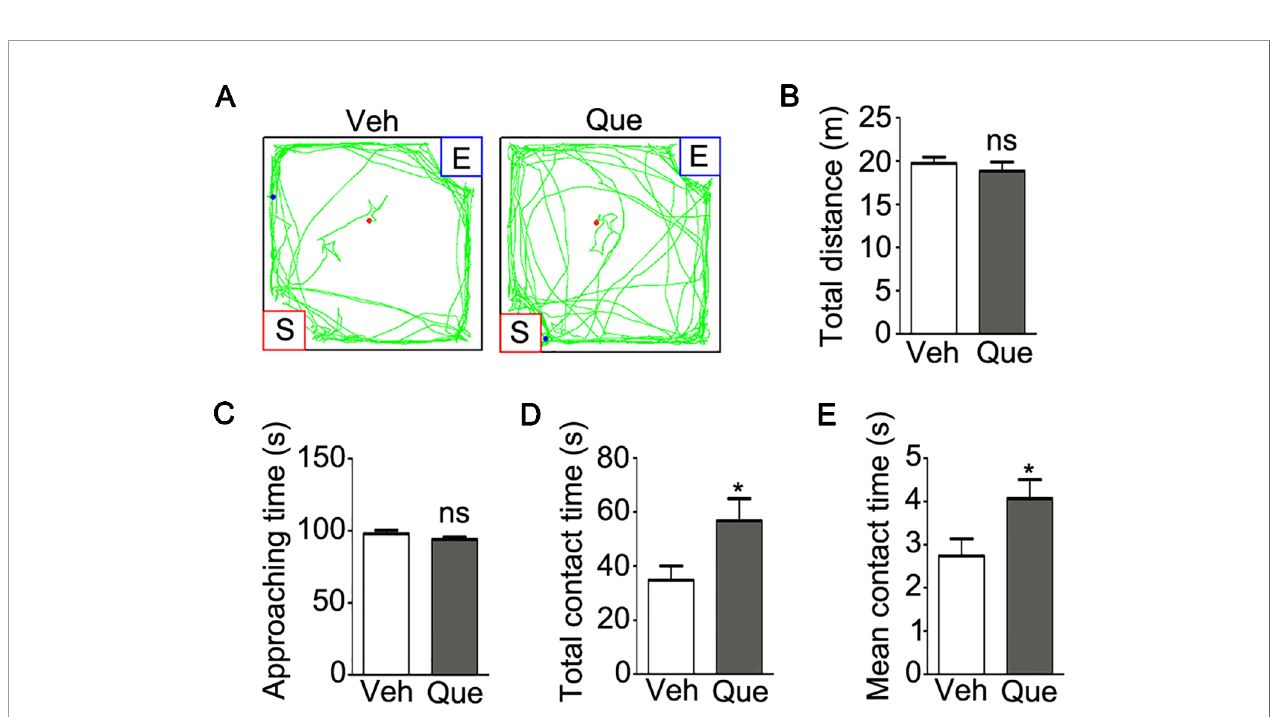
FIGURE 4 | Analyses of sociability in isolated mice after quetiapine treatment. (A) an example of the travel pathway of tested mice in social interaction test. Graphs show the total distance traveled (B) , duration of approaching to the stranger mice (C) , duration of total contact (D) and mean duration for each contact (E) in isolated mice treated with vehicle (Veh, n = 12) or quetiapine (Que, n = 13). Data are expressed as mean ± SEM. *P < 0.05; ns, no signi fi cant